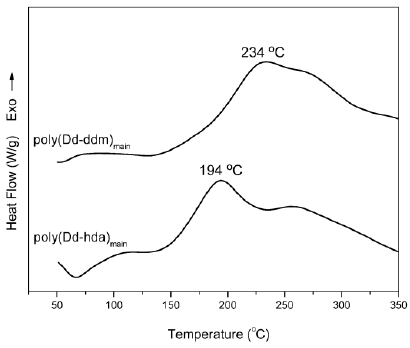
Figure 2. Differential scanning calorimetry (DSC) thermograms of poly(Dd-ddm) main and poly(Dd-hda) main .